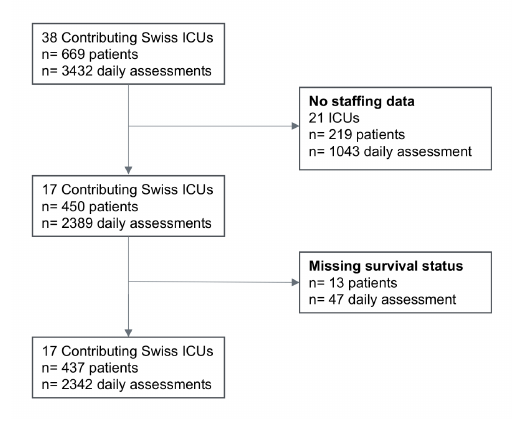
Figure 1: Study Flow Chart. During the first epidemic wave. ICU = Intensive Care Unit, n =